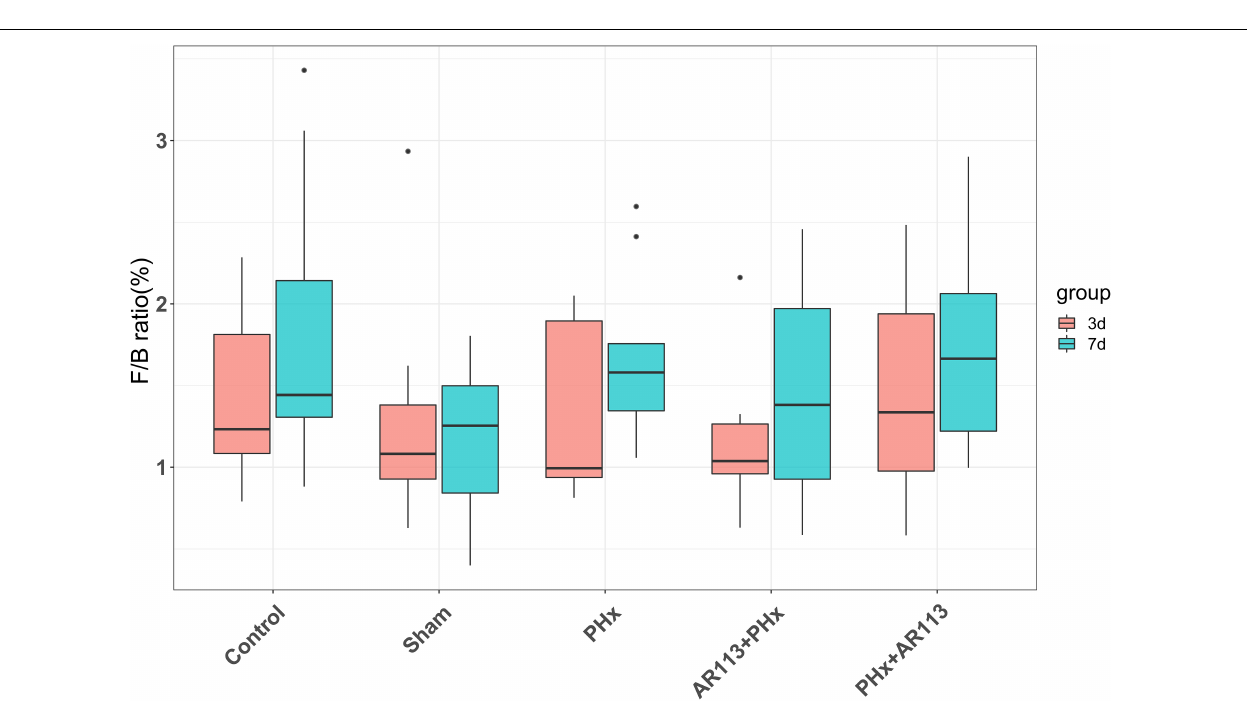
FIGURE 5 | The Firmicutes-to-Bacteroidetes ratio (F/B) of Control, Sham, PHx, AR113+PHx, and PHx+AR113 groups.